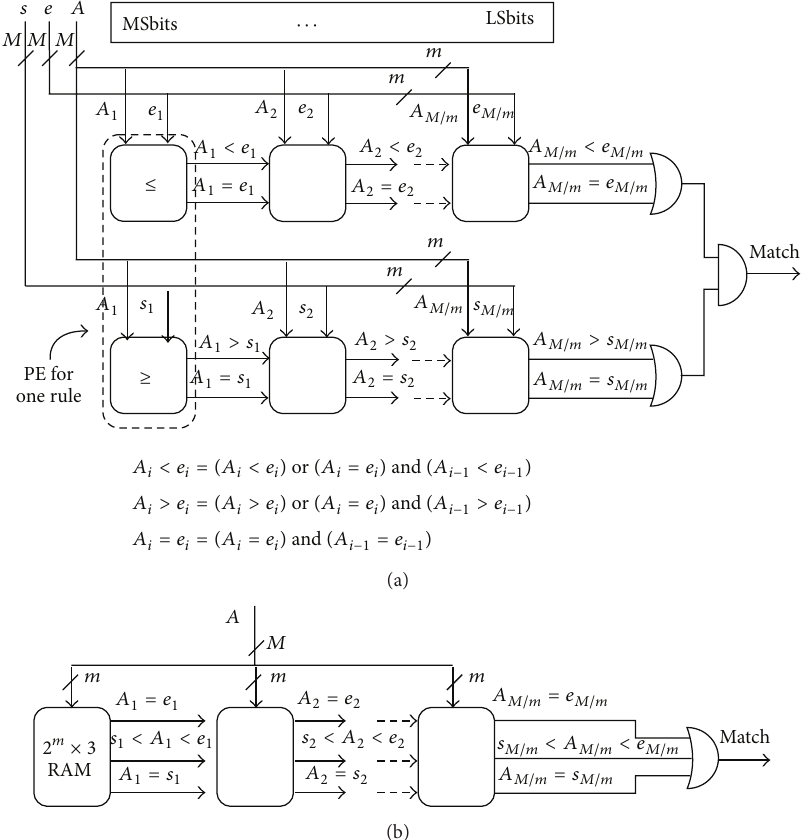
Figure 16: Single-rule lookup: (a) stitched magnitude comparators for ERM and (b) equivalent implementation through stitched IND.